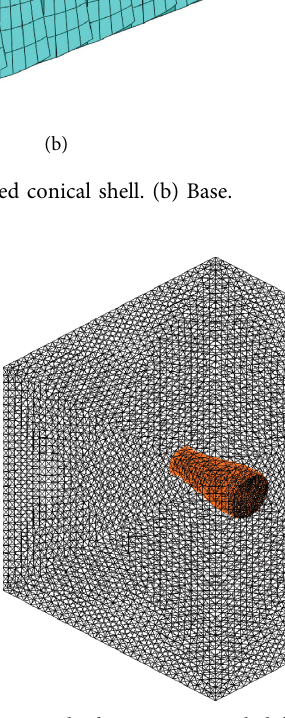
Figure 2: Fluid-structure coupled finite element